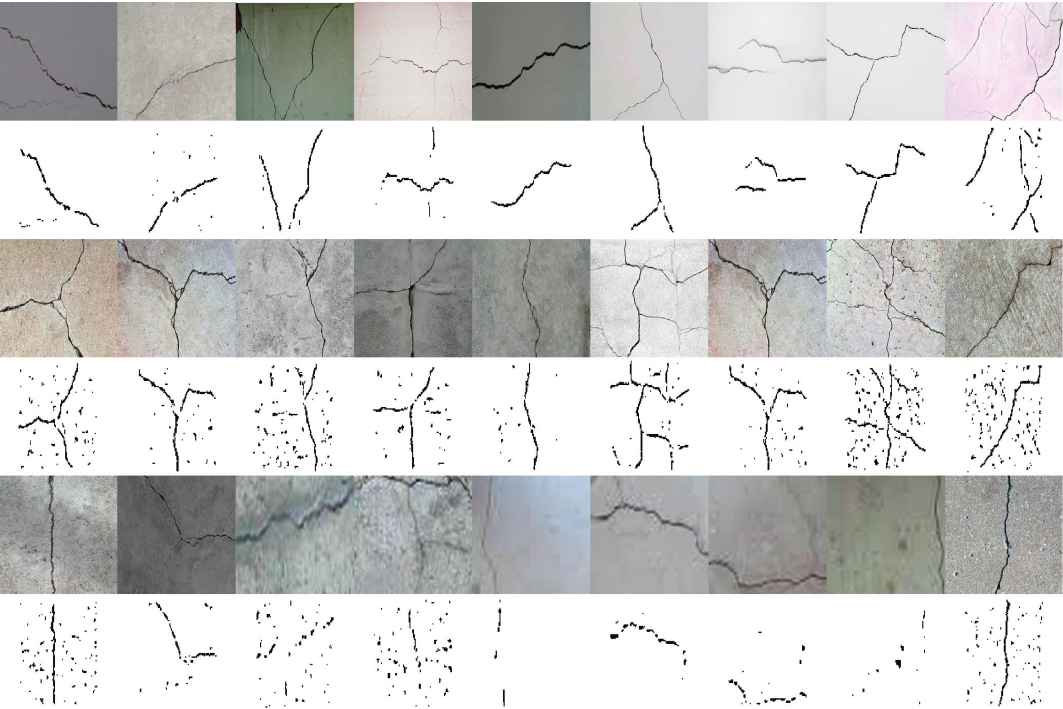
Figure 35: Percolation results using the enhanced percolation method with the quadratic stride.